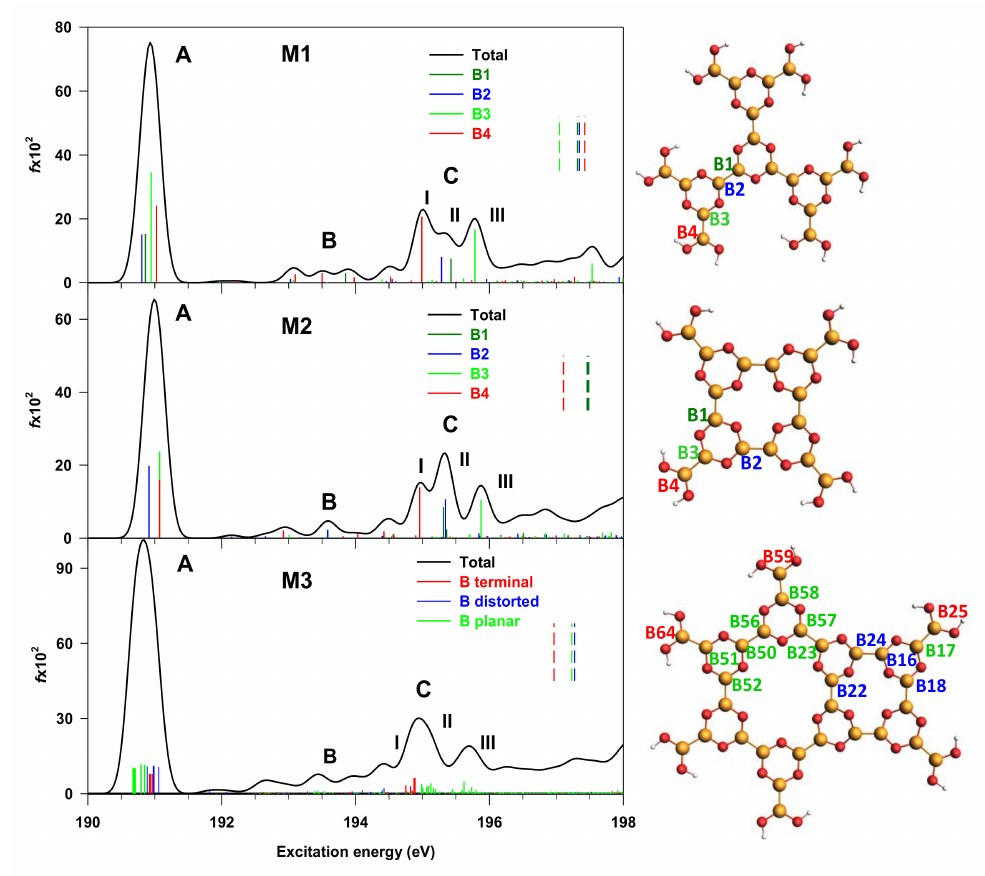
Figure 3. Calculated B1s NEXAFS spectra of M1 ( upper panel ), M2 ( middle panel ) and M3 ( lower panel ) molecular models depicted on the right side. Labels denote the non-equivalent B i sites (see text for explanation). Transitions from the non-equivalent B i atoms are reported as vertical colored lines in the spectra. The ∆ SCF B1s ionization energies are shown as vertical dashed lines (the IP values are reported in Supplementary Table S1). The stick spectra are broadened by using a Gaussian line shape with FWHM = 0.3